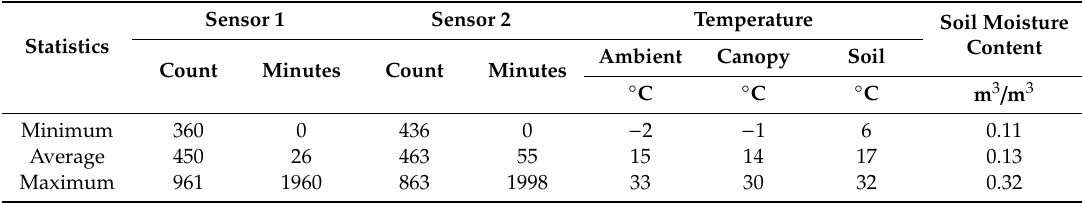
Table 2. Statistics of the measured attributes in the field.